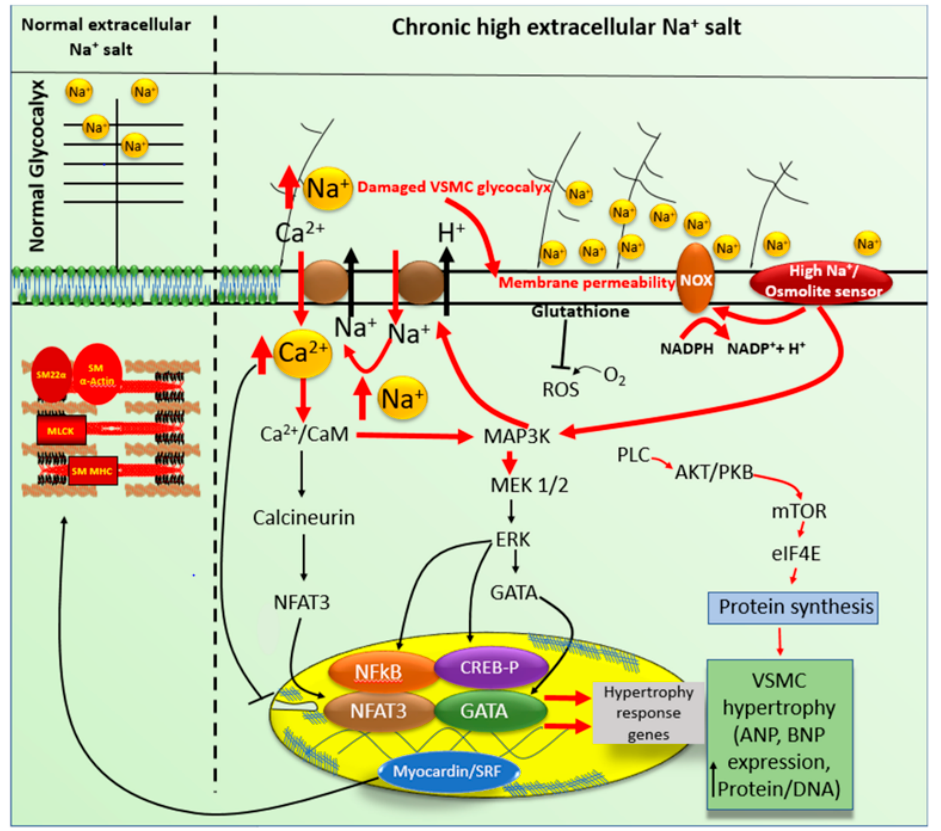
Figure 3. Schematic representation summarizing the literature on the glycocalyx, plasma membrane Na + transport, and Ca 2+ -dependent signaling and transcription factors that could be implicated in chronic high salt induced vascular smooth muscle and endothelial cells. ROS: reactive oxygen species; Ca 2+ /CaM: calcium calmodulin; VSMC: vascular smooth muscle cells. Modified from Bkaily et al., 2021 [2].